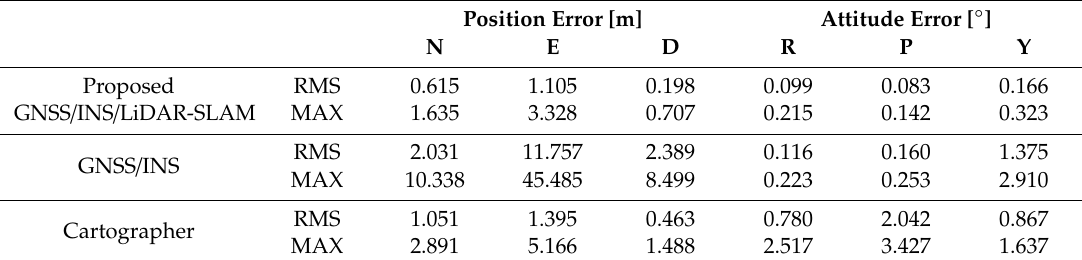
Figure 16. Position and attitude errors of Cartographer in the urban area test. Table 3. Error statistics for the urban area test.